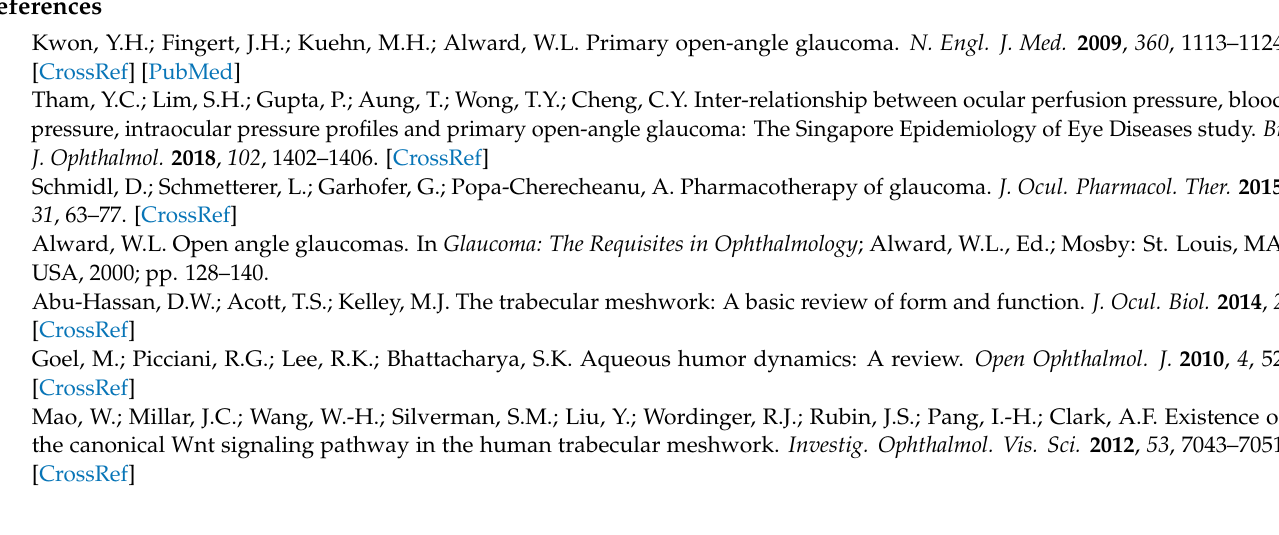
Table S2: The STR results of Cell line ID: NPCE